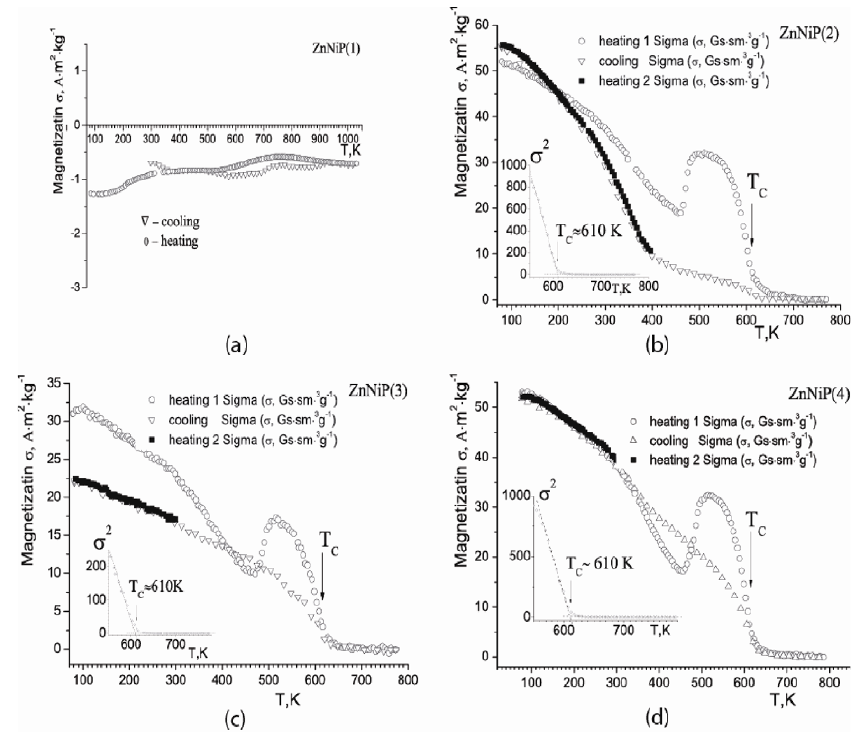
Figure 12. Magnetic measurements for samples: a) ZNP(1); b) ZNP(2); c) ZNP(3); d)